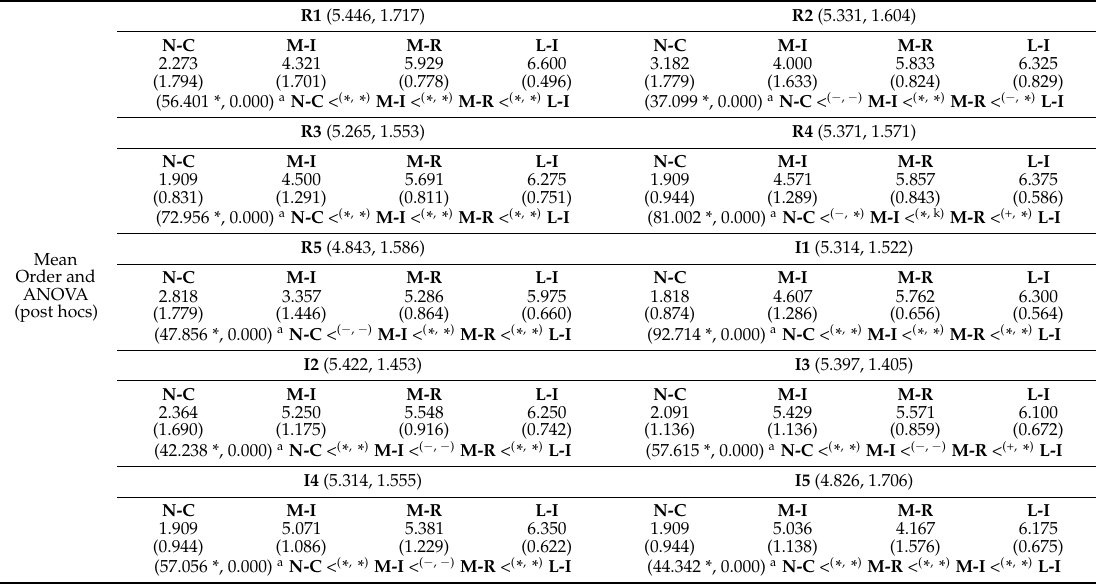
Table A1. Statistical differences between the factors used in the clustering (mean, standard deviation, ANOVA, and post hoc